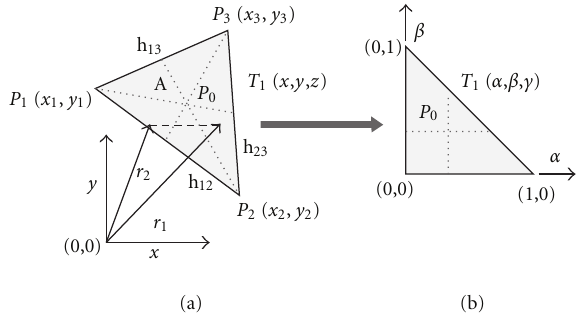
Figure 2: Self-term evaluation. (a) Original problem, (b) simplex coordinates transformation [23].